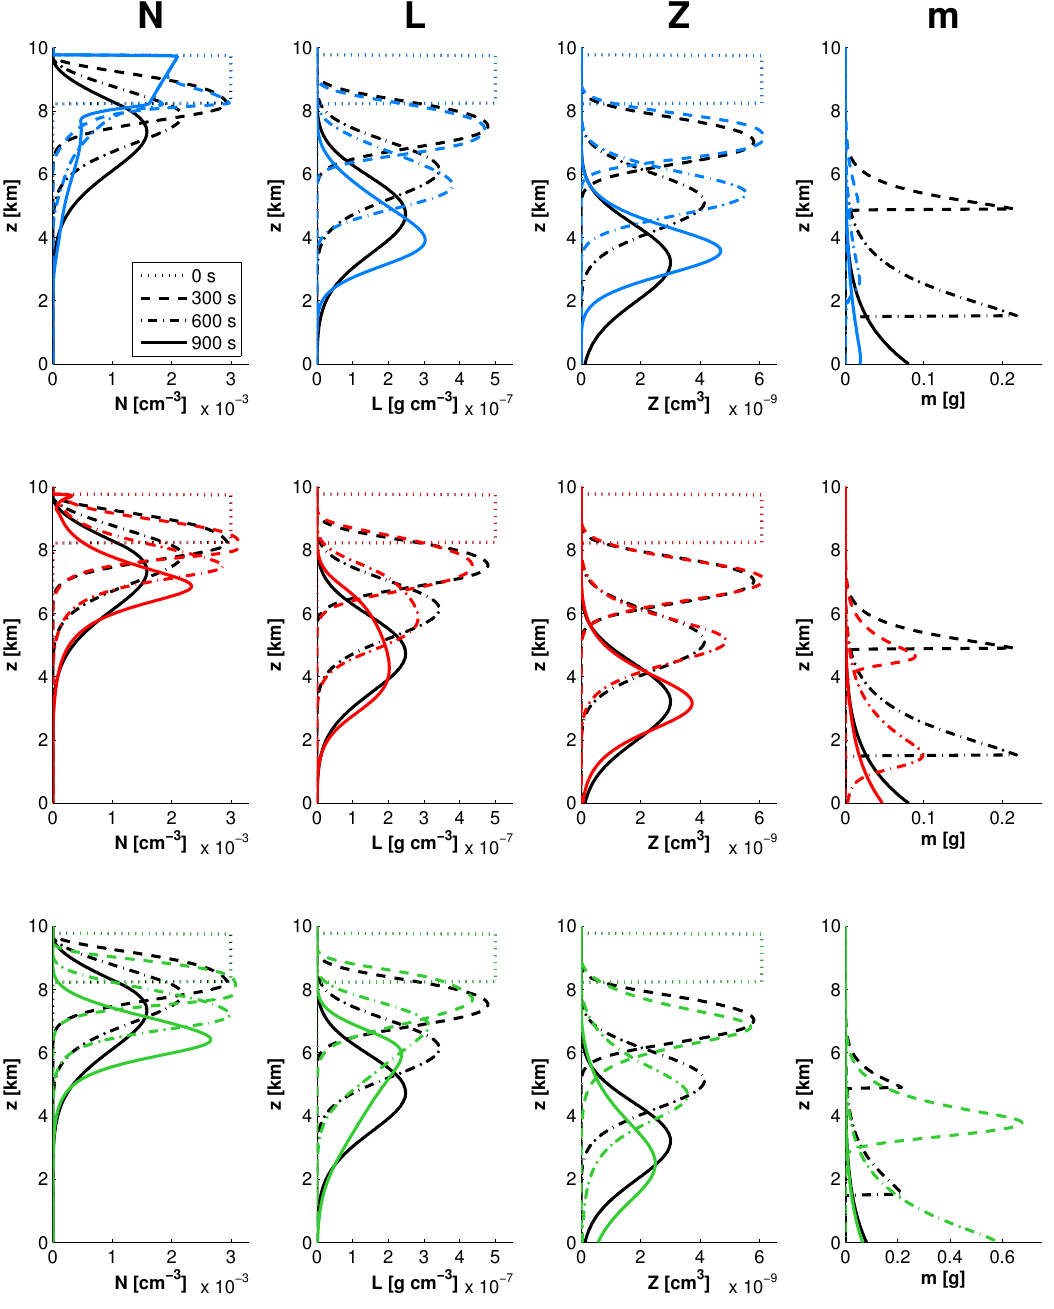
Profiles of N , L , Z and m for the spectral reference solution (black), MOM3- B (blue,top), MOM3- Γ (red,middle) and MOM3-log-normal (green, bottom). Note the different scaling of the x-axis for m . Results are valid for the BOX case (rectangular l-n initial signal of the moments; see Section